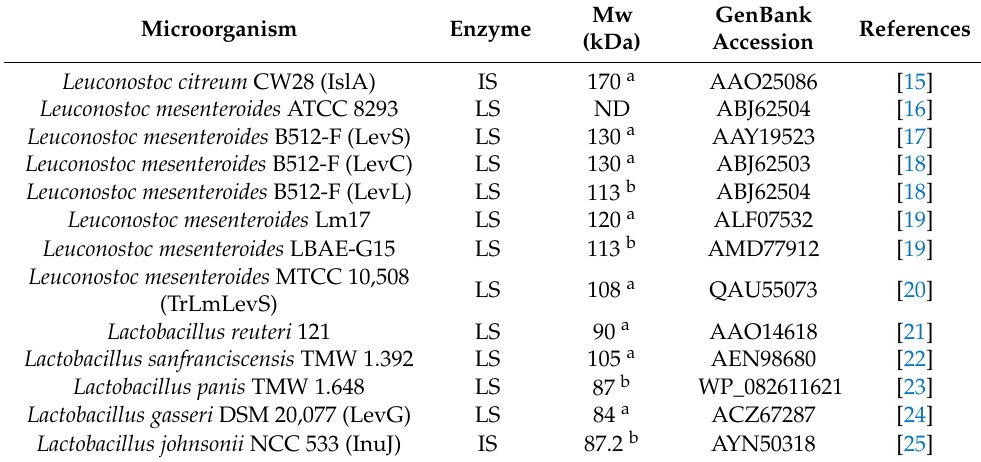
Table 1. Multidomain fructansucrases from Lactobacillales